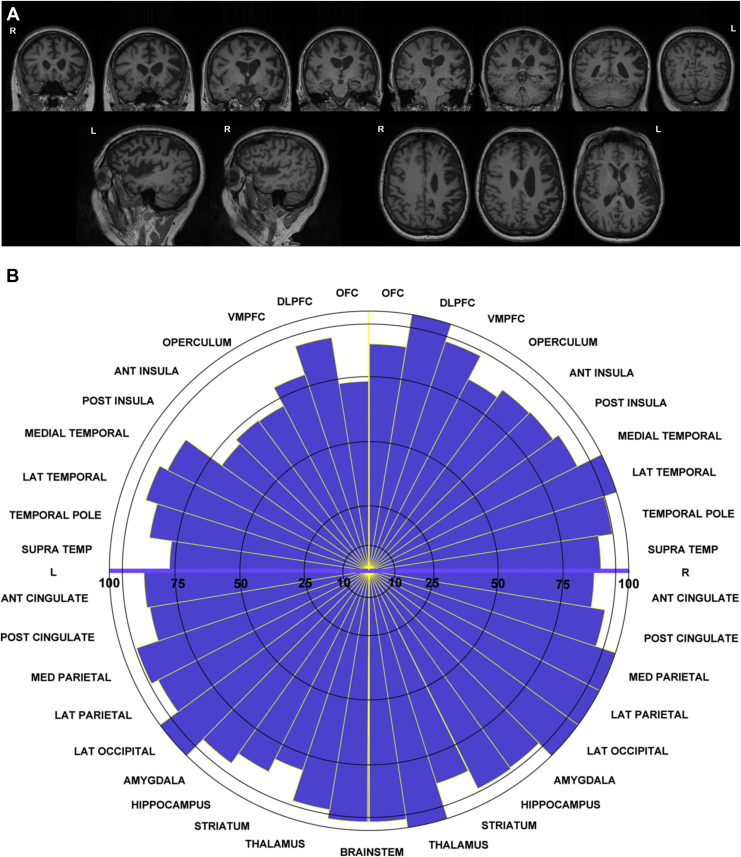
MRI and target diagram showing pattern of atrophy in the patient. (A) T1-weighted images from a 3T MRI scan of the patient at 5.5 years disease duration. Top row: coronal sections; bottom row: sagittal sections (on the left) and axial sections (on the right). Asymmetrical left greater than right hemisphere atrophy is seen with frontal, superior temporal, and parietal involvement. (B) Target diagram showing atrophy seen in different brain regions. Segment length represents the regional volumes of the patient expressed as percentages of the mean volumes of an age-matched healthy control cohort. Abbreviations: OFC, orbitofrontal cortex; DLPFC, dorsolateral prefrontal cortex; VMPFC, ventromedial prefrontal cortex; MED, medial; LAT, lateral; SUPRATEMP, supratemporal cortex; ANT, anterior; POST, posterior.